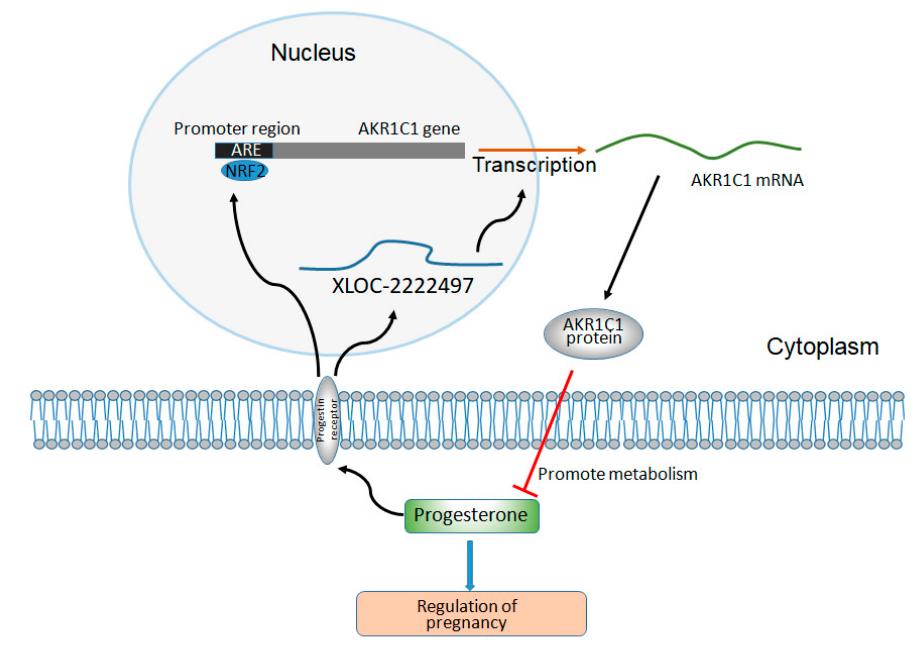
Figure 7. The regulation diagram of XLOC-2222497, AKR1C1 , and progesterone .